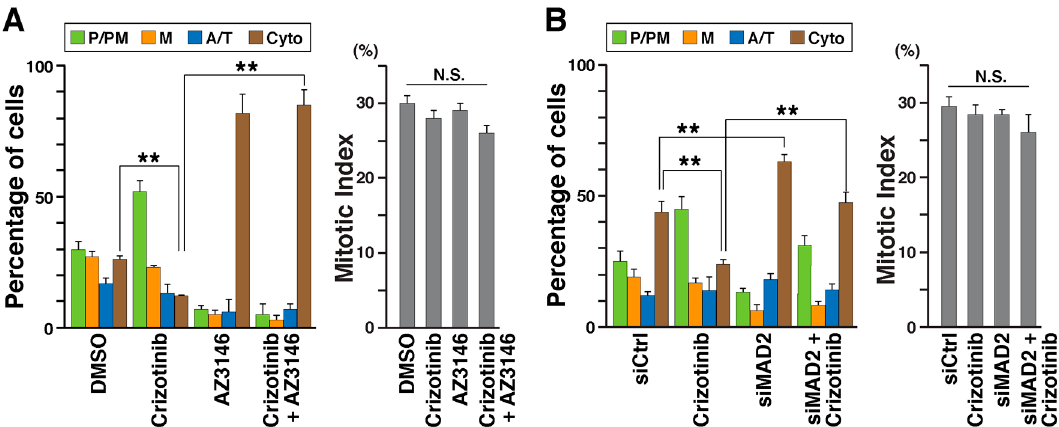
Figure 5. SAC is involved in crizotinib-induced M phase delay. ( A ) SH-SY5Y cells were synchronized with 4 µ M RO-3306 and released in the presence of 0.5 µ M crizotinib, 4 µ M AZ3146, or a combination of both for 45 min. ( B ) SH-SY5Y cells were transfected with siMAD2 and 28 h later the cells were synchronized using RO-3306. Then, they were released with or without 0.5 µ M crizotinib treatment for 45 min. M phase cells were classified into four groups as described in Figure 1C. The percentages of cells in subphases ( A , n > 256; B , n > 240, in each experiment) and mitotic indices ( A , n > 464; B , n > 470, in each experiment) are plotted as mean ± SD, calculated from three independent experiments. The Tukey–Kramer multiple comparison test was used to calculate p values. ** p < 0.01; N.S., not